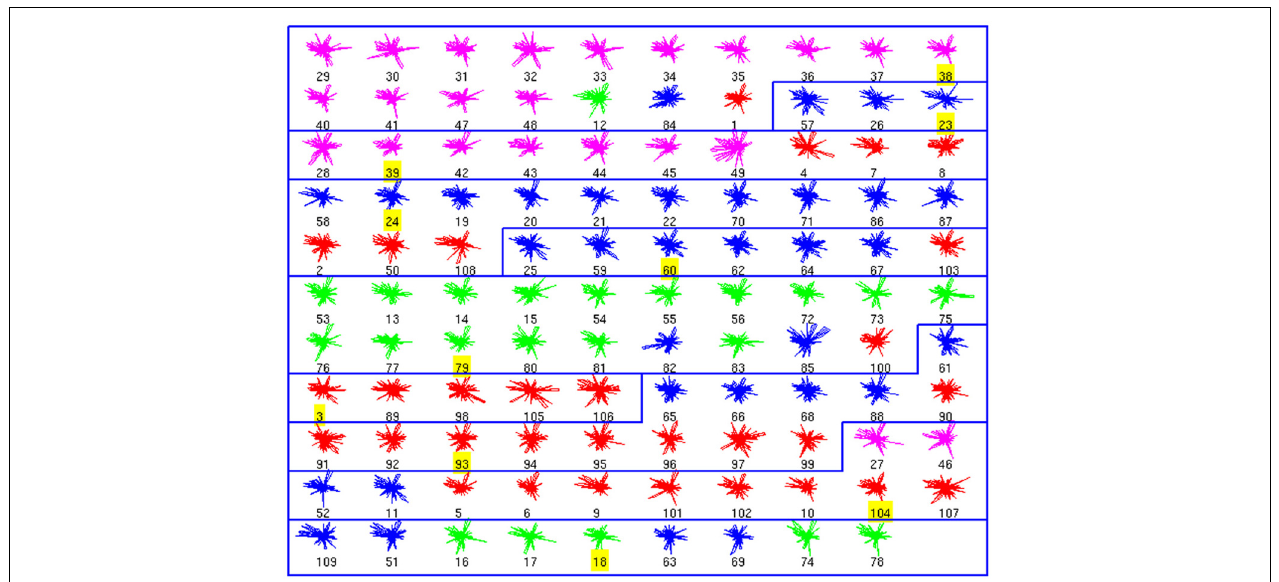
FIGURE 1 | Morphological Clusters. Neurons are represented as colored glyphs. Colors red, blue, green, and magenta, respectively, represent neuron types BC, MC, non-MC, and ChC. The label of the exemplar in each cluster is shaded in yellow. Ten clusters are found; most clusters are dominated by a